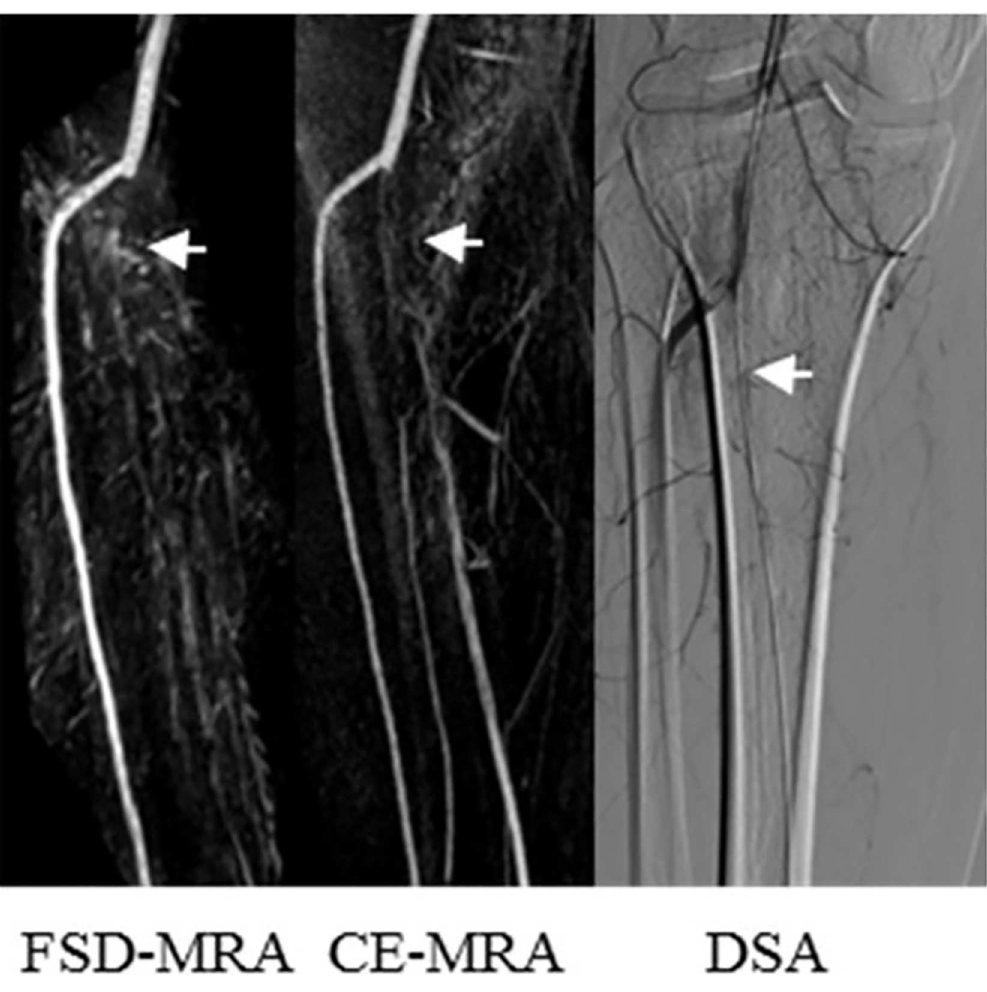
Fig 2. Images from a 37-year-old male patient who had been suffering from intermittent claudication for 2 weeks. Consistent with CE-MRA and DSA, FSD-MRA demonstrated an occlusive lesion on the right tibiofibular trunk (white arrow). Due to inhomogeneous background suppression, the distal right posterior tibial artery and right fibular artery are not shown clearly in the FSD-MRA image.